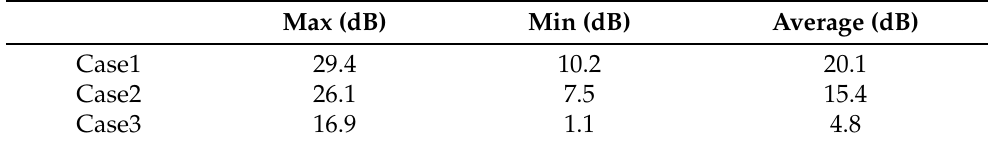
Table 1. Experimental